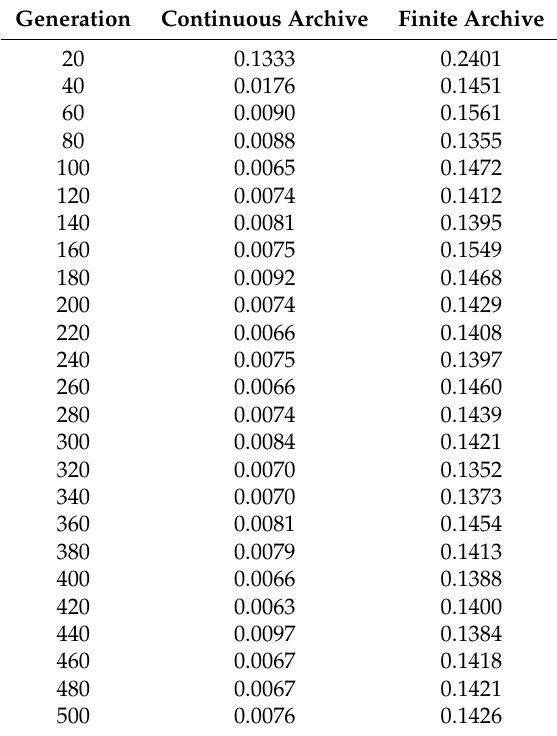
Table 9. ∆ p , q results between the Pareto Front and its respective discrete and continuous approximations of NSGA-II for MOP (Equation (17)): The data shown is the averaged over the 20 independent runs